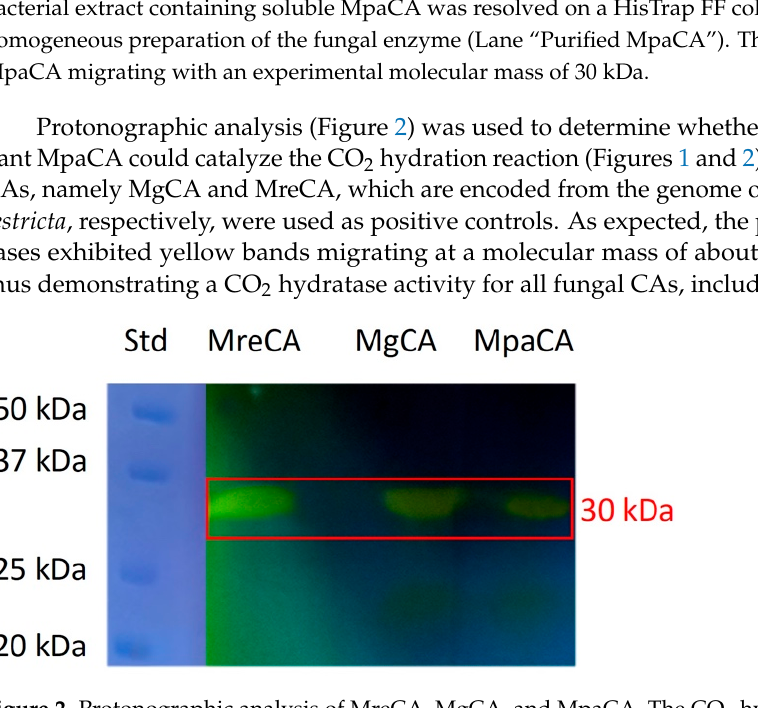
Figure 2. Protonographic analysis of MreCA, MgCA, and MpaCA. The CO 2 hydratase activity was directly evaluated on the polyacrylamide gel through the development of yellow bands due to pH value variations (acidic pH) resulting from the conversion of CO 2 to bicarbonate and protons (H + ). Legend: Lane Std, molecular markers; Lane MreCA, purified MreCA; Lane MgCA, purified MgCA; Lane MpaCA, purified MpaCA. The red box shows the enzyme activity of the three fungal enzymes, which migrated with an apparent molecular mass of about 30 kDa. With the aid of the stopped-flow technique, we further demonstrated that MpaCA exhibits an appreciable CO 2 hydrase activity, with a k cat value of 3.8 × 10 5 s − 1 and k cat /K M value of 9.7 × 10 6 M − 1 s − . MgCA and MreCA showed a catalytic activity very similar to that of MpaCA. In particular, MreCA showed a k cat value = 1.06 × 10 6 s − 1 and k cat /K M value = 1.07 x 10 8 M − 1 s − 1 [25], while MgCA exhibited a k cat value of 9.2 × 10 5 s − 1 and k cat /K M value of 8.3 × 10 7 M − 1 s − 1 [27–33].